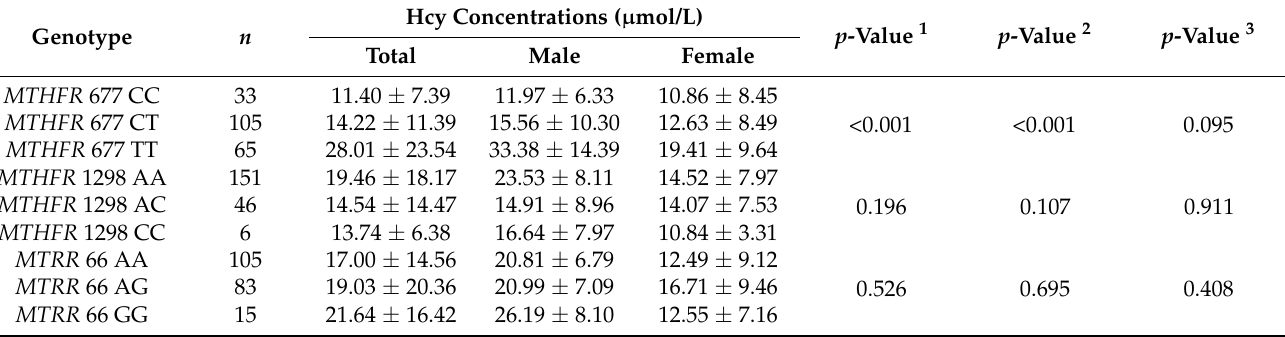
Table 2. Comparison of Hcy concentrations among different genotypes in sex subgroups.